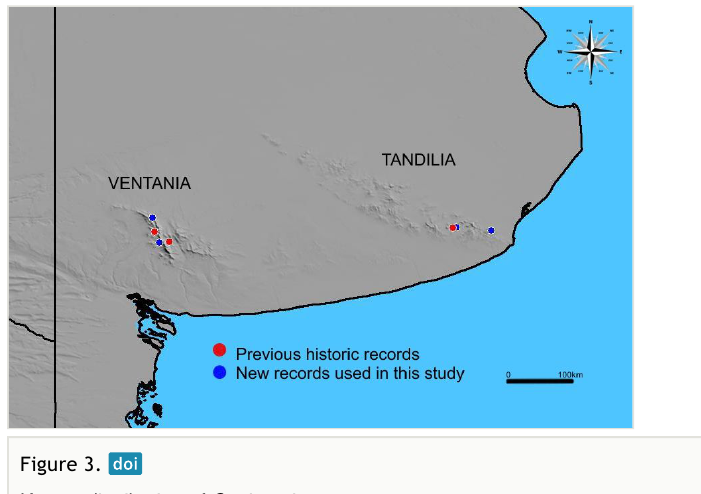
Known distribution of C.